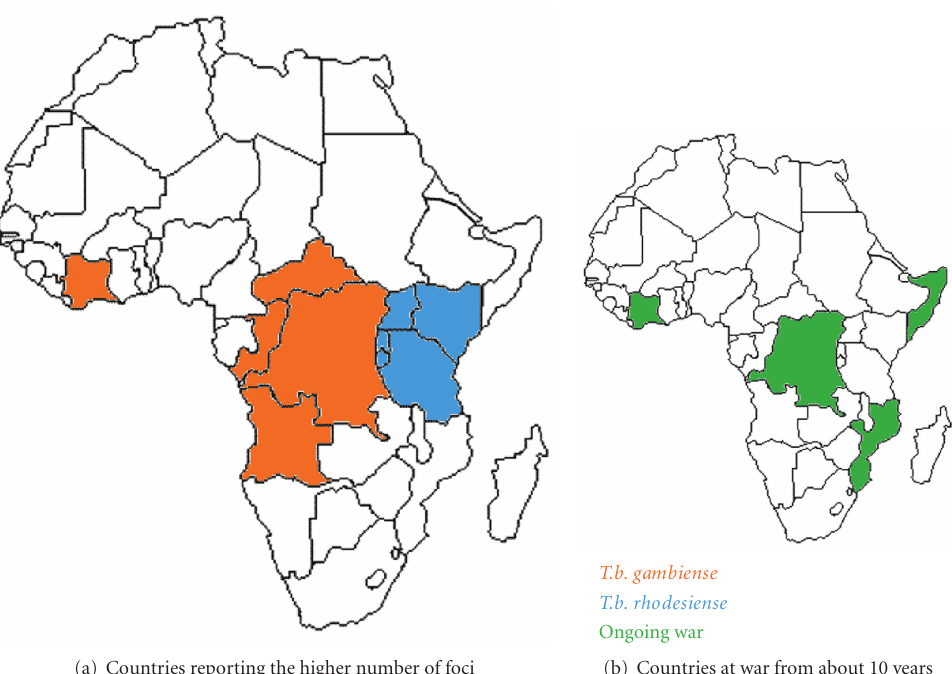
Figure 1: African trypanosomiasis repartition and sociopolitical instability. (a) Illustration of the geographical repartition of the countries reporting the higher number of foci of both T.b. subspecies causing HAT. (b) Illustration of the geographical repartition of the countries at war from more than 10 years. Note the correlation between countries at war and the localization of foci of T.b. gambiense . HAT cases occur more often in countries with conflict, high political terror, or civil war, with a lag of about 10 years between the conflict beginning and peak in incidence [12]. Epidemiological data are from